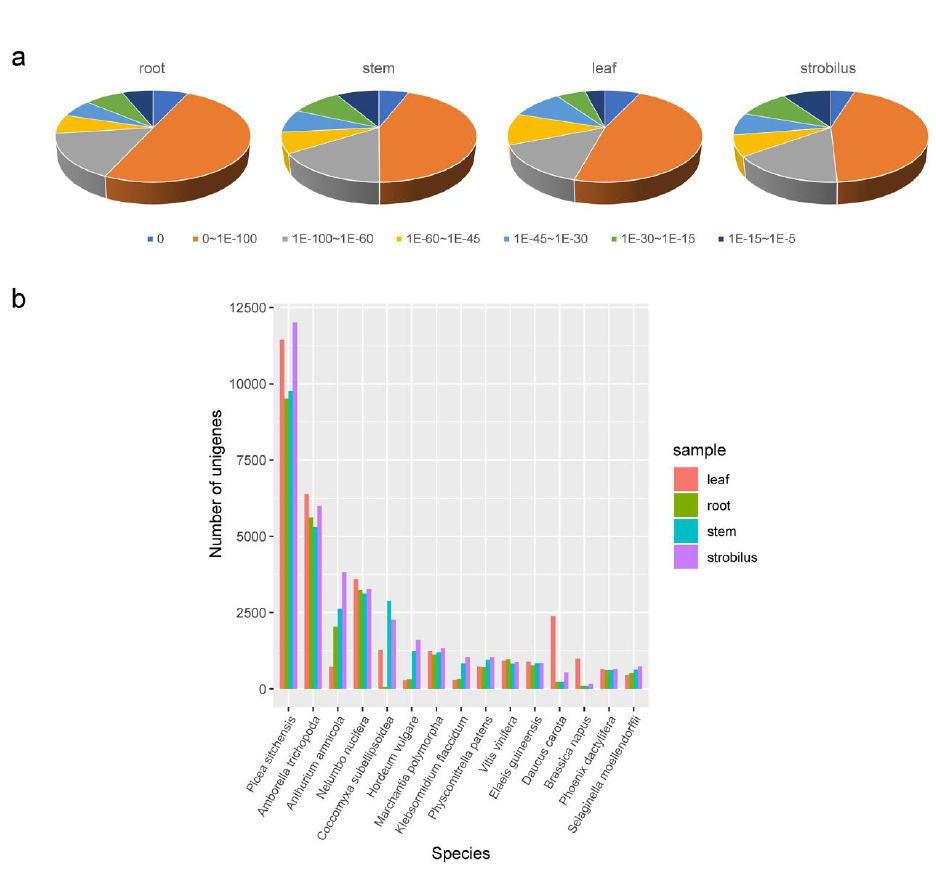
Figure 2. The distribution of homologous species annotated in the NCBI non-redundant protein (Nr) database. ( a ) The E -value distribution of the hit unigenes; ( b ) Top 10 hit species for unigenes identified in the four organs of P. chienii .